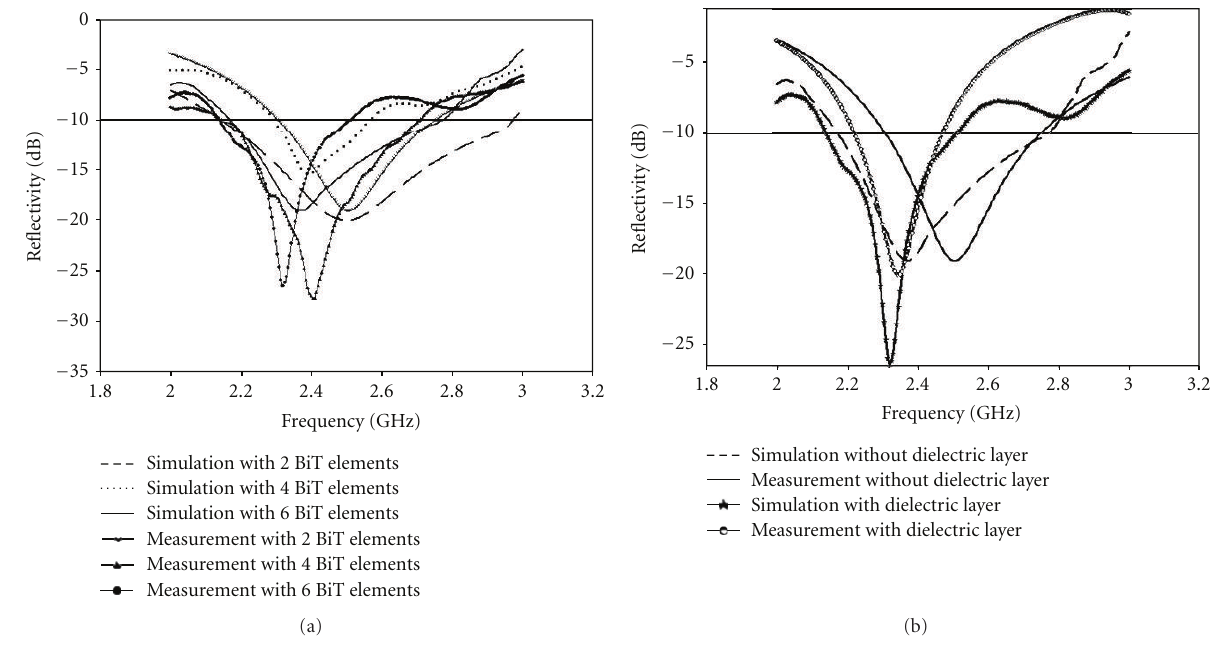
Figure 7: Simulated and measured reflectivity of the proposed BiT array antennas (a) two-, four-, and six-BiT element array antenna (b) with and without the dielectric layer.